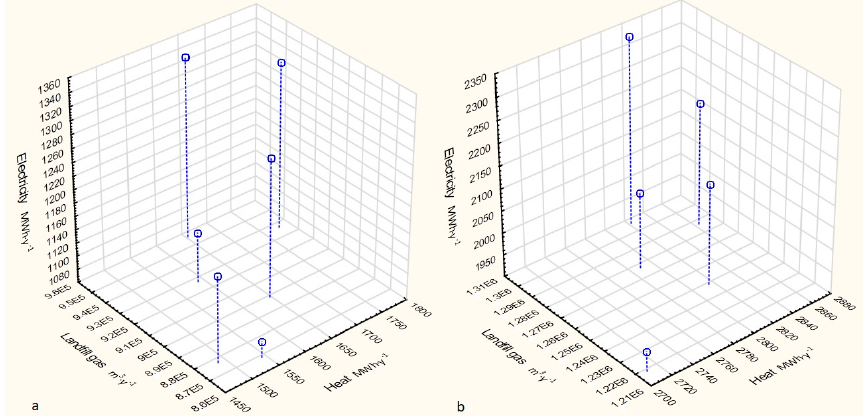
Figure 3. Biogas volume for the generation of electricity and heat in the CHP plant: ( a ) before opti-